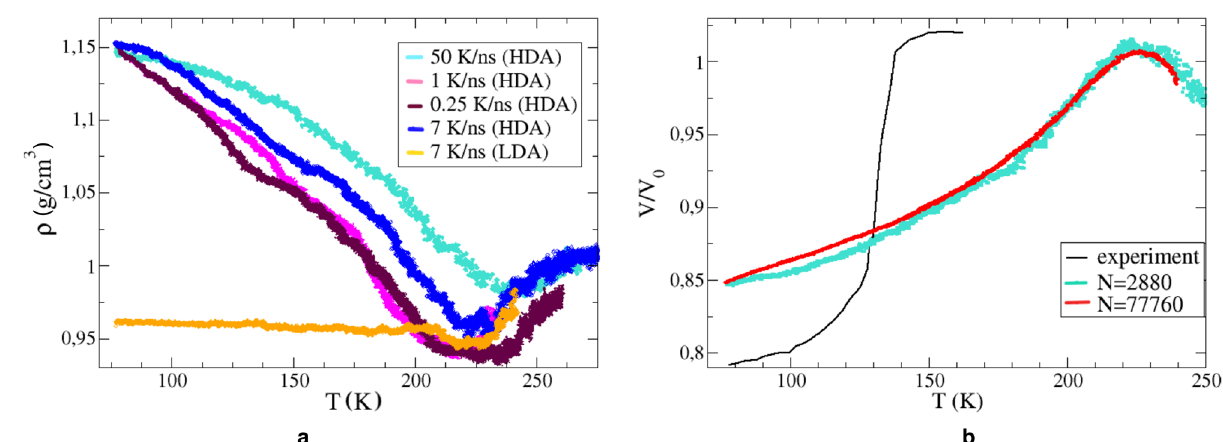
Figure 6. ( a ) The temperature dependencies of density during the isobaric heating of HDA for several heating rates. The orangeline shows the dependence in the process of heating of LDA at the rate of 7 K/ns. ( b ) The absence of the size effect duringisobaric ( P = 0.05 GPa) heating of HDA. The MD-heating rate is 7 K/ns; the experiment 30 assumes much slower